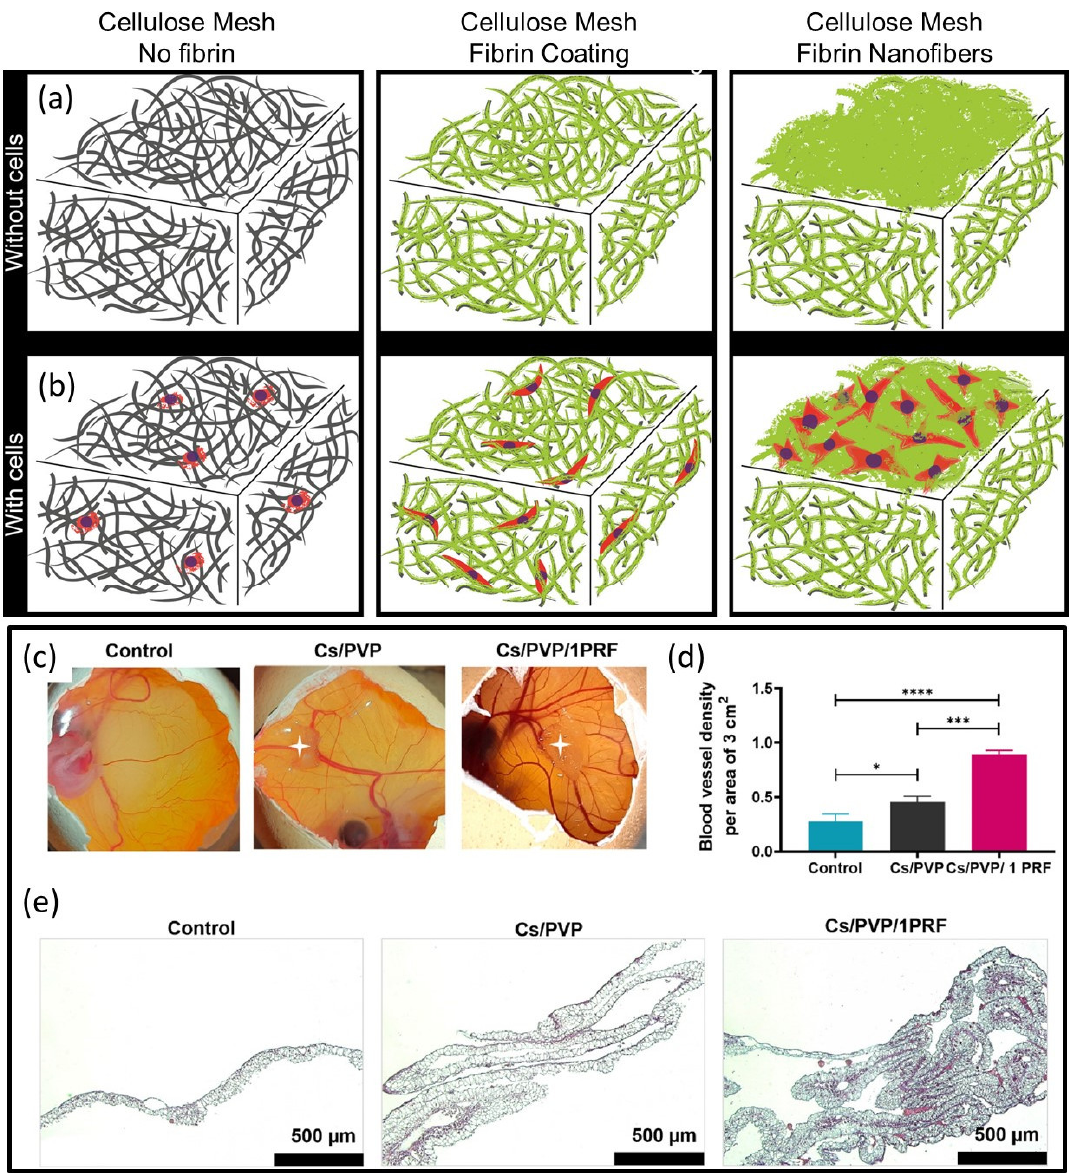
Figure 6. Schematic description of wound dressings fabricated from sodium carboxymethylcellulose combined with fibrin and seeded with dermal fibroblasts in vitro. ( a ) Series of porous structures of pure cellulose, cellulose coated with fibrin and cellulose coated with fibrin nanofibers with no cells. ( b ) Same as ( a ), but with cell seeding. ( c ) Images related to the angiogenic potential of various wound dressings assessed with the CAM assay. ( a – c ) Reprinted/adapted with permission from Ref. [48]. 2018, MDPI. ( d ) CAM blood vessel density in different groups. ( e ) Histological images of CAMs associated with different studied groups stained with Masson’s trichrome (cell nuclei are red and collagen bundles are blue). Statistical significances are shown as * p < 0.05, *** p < 0.001 and **** p < 0.0001 in ( d ). Reprinted/adapted with permission from Ref. [48]. 2022, Elsevier.